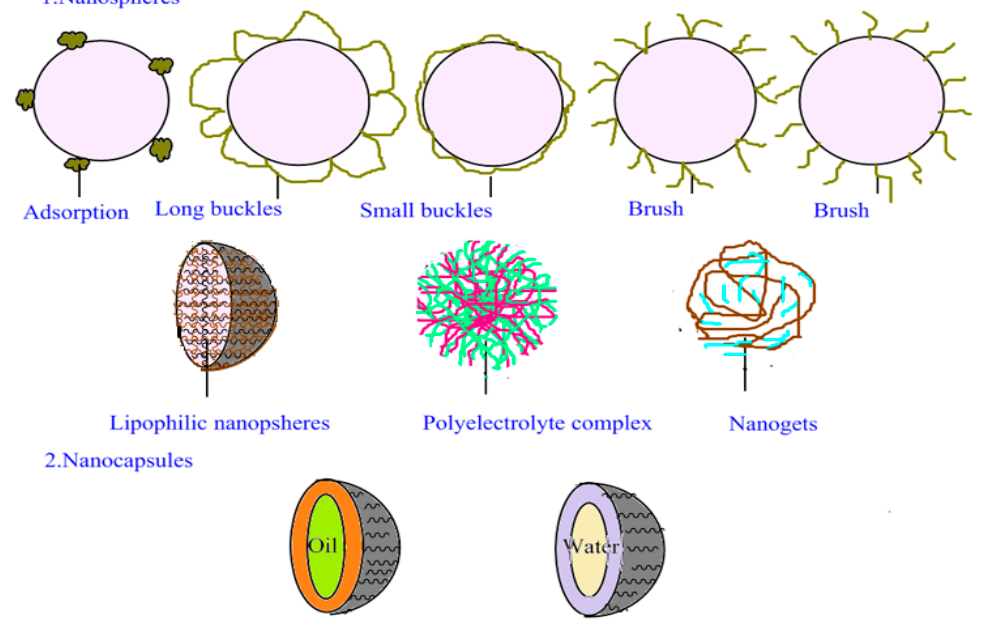
Figure 2. Schematic diagram illustrating structures of two types of PNPs. 1 and 2 are polymer nanospheres and polymer nanocapsules, respectively.